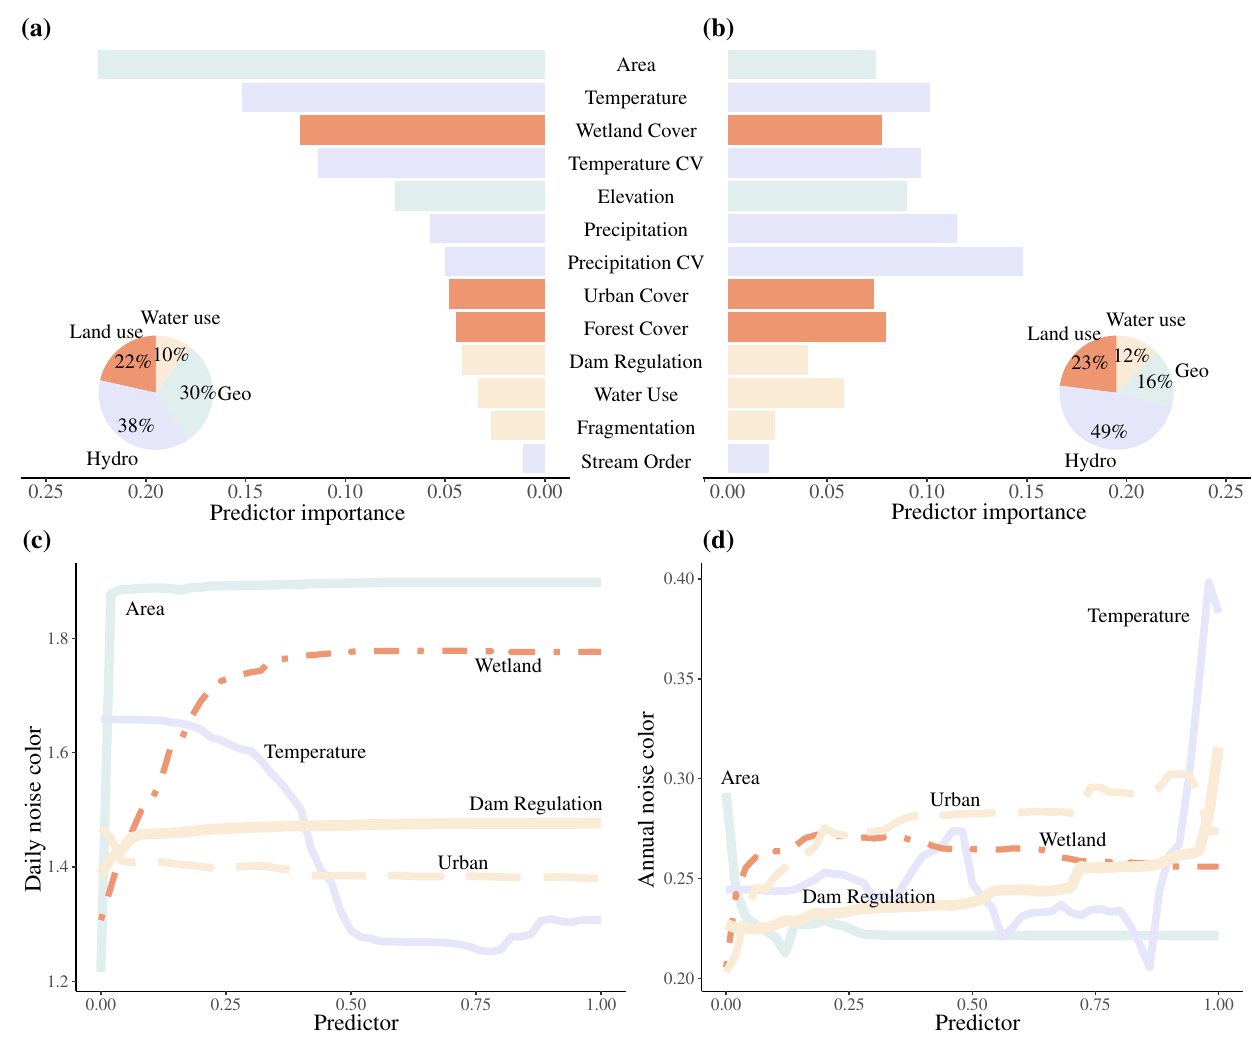
the variables after normalizing them between 0 and 1. The color of bars in a , b indicate the different driver categories: hydroclimate ( Hydro ), geography ( Geo ), land use – land cover ( Land use ), and human activities on the water cycle (Water management, indicated as Water use ). The relative importance of each driverwasevaluatedusing random forest models(seeMethods formodeldetails), and is illustrated via pie charts by driver